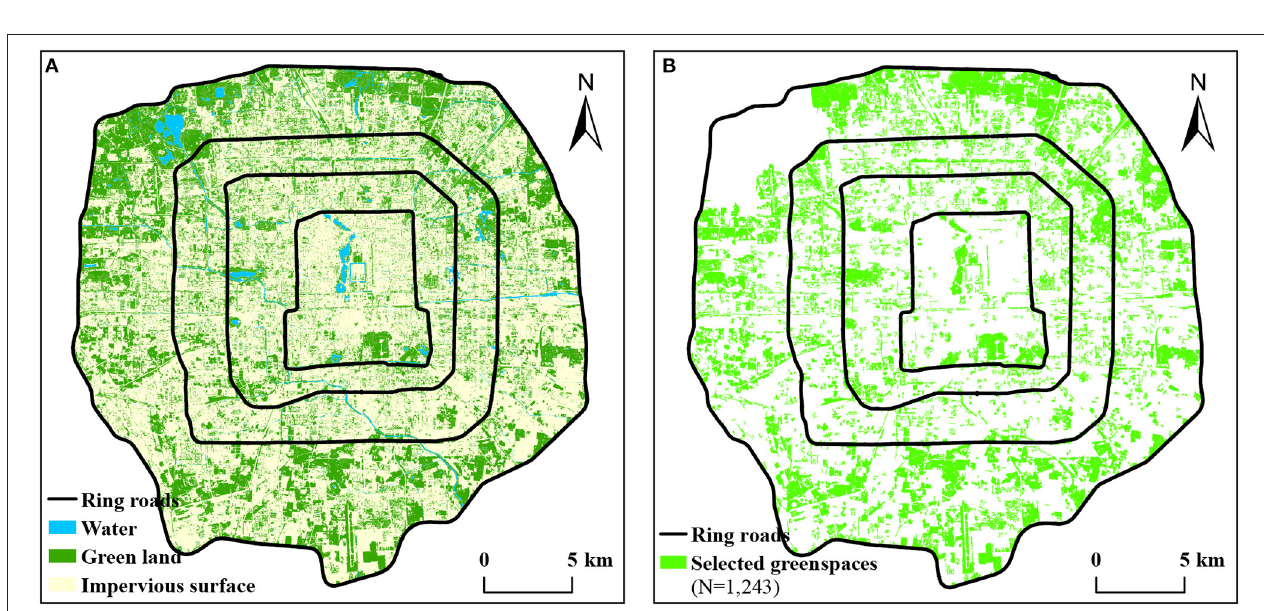
FIGURE 2 | Spatial distribution of LST (A) and cold-hot islands at different levels (B) in the study area. Where ALST is the average LST; std is the standard deviation of LST in the study area.